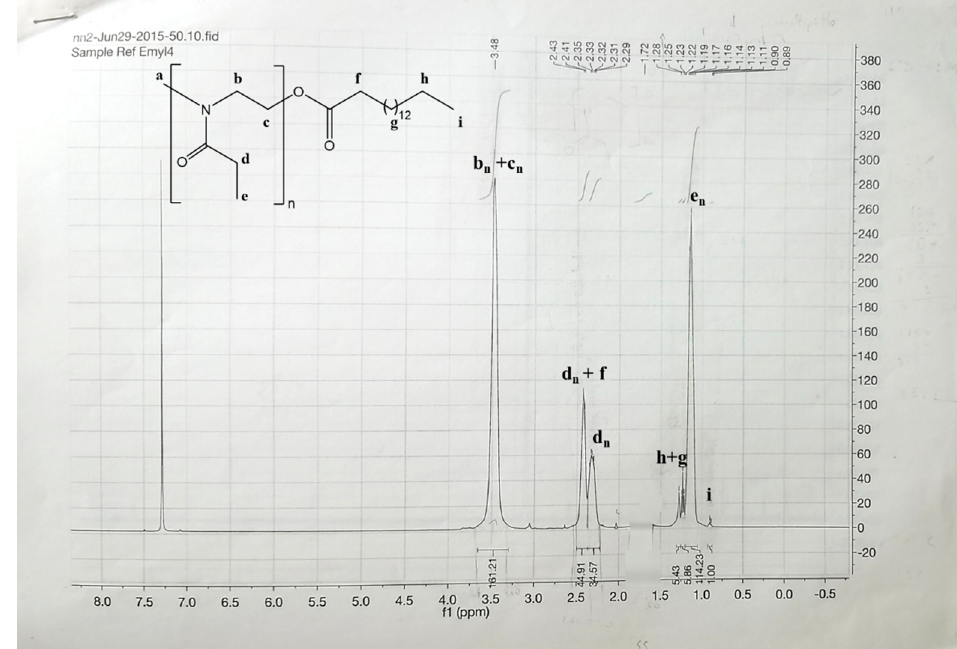
Figure 1. 1 H-NMR of PEtOz-PA.